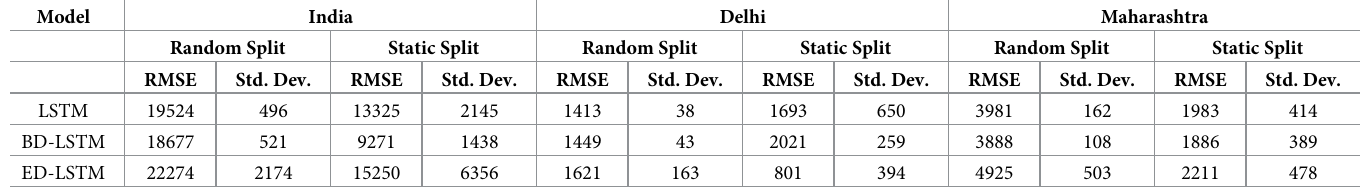
Table 8. Multivariate model prediction accuracy on the test dataset (RMSE mean and standard deviation for 30 experimental runs across 4 prediction horizons).